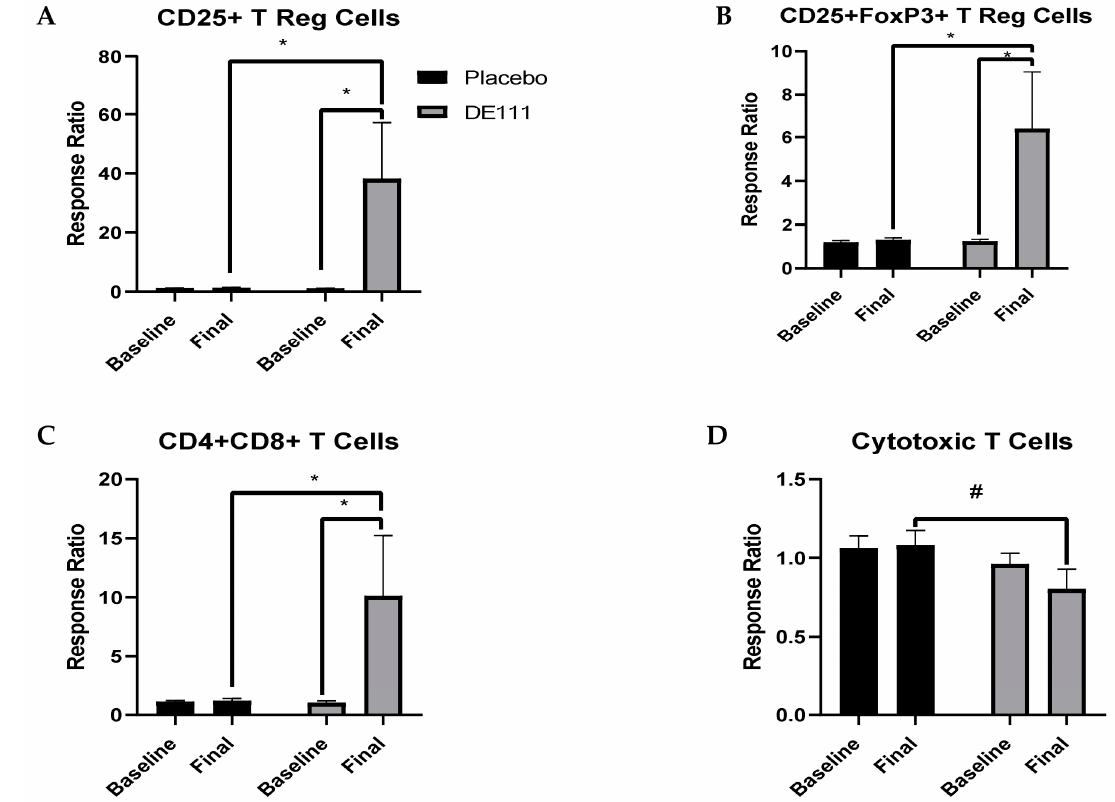
Figure 6. Cellular responses to LPS stimulation, calculated as stimulated/basal cell counts for CD25+ ( A ) and CD25+FoxP3+ ( B ) regulatory T cell populations, as well as double-positive CD4+CD8+ T cells ( C ) and CD8+ cytotoxic T cells ( D ). Error bars represent ± SEM. * denotes p < 0.05 and # denotes a p -value between 0.05–0.08. Table 3 . Statistical analysis (Mixed-Effects Model with Sidak post hoc comparisons) for LPS-in- duced response ratios of significant and trending changes in immune cell populations.